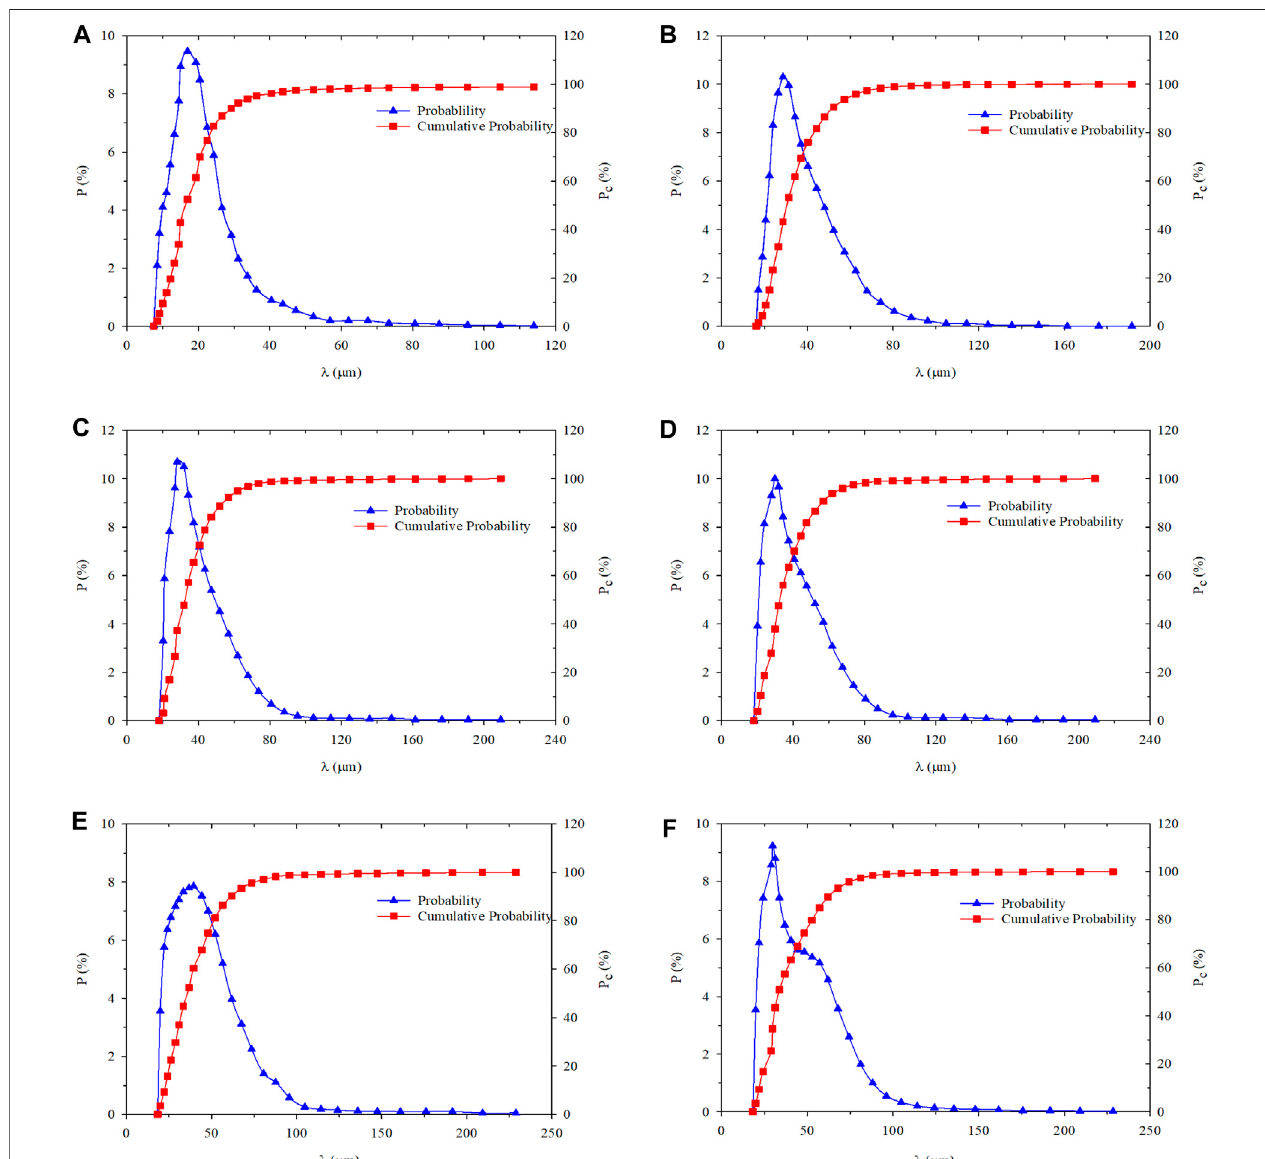
FIGURE2| SizeprobabilityandthecumulativeprobabilitydistributionofPMsversusdifferenthydrationtime: (A) Hydrationinitialstate; (B) Hydrationtime1day; (C) Hydration time 3 days; (D) Hydration time 5 days; (E) Hydration time 10 days; (F) Hydration time 30 days.